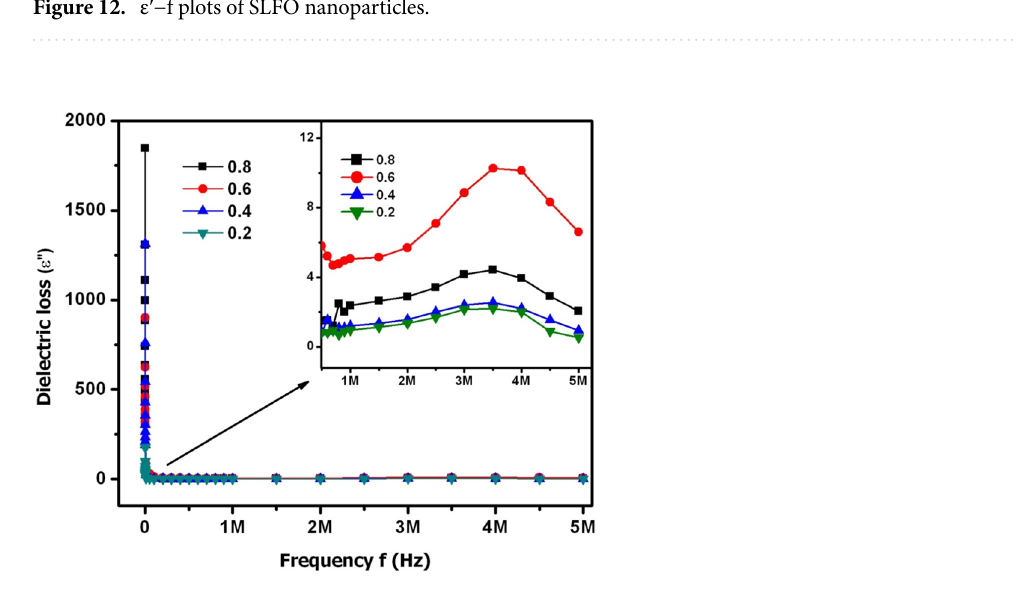
Figure 13. ε ″ −f plots of SLFO